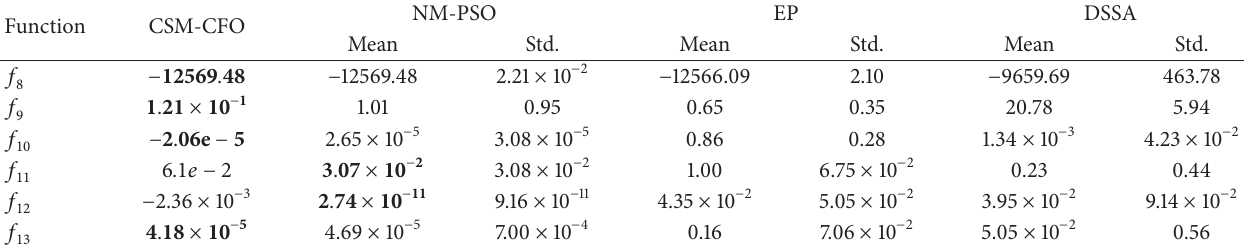
Table 5: Minimization result of benchmark functions in Table 2 with 𝑛 = 30